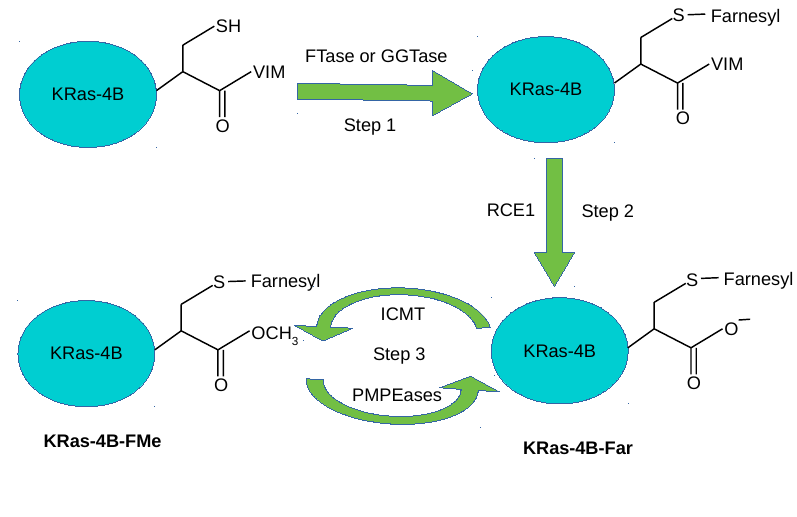
Figure 1. Post-translational modifications (PTMs) steps of KRas-4B: prenylation, hydrolysis, carboxymethylation and